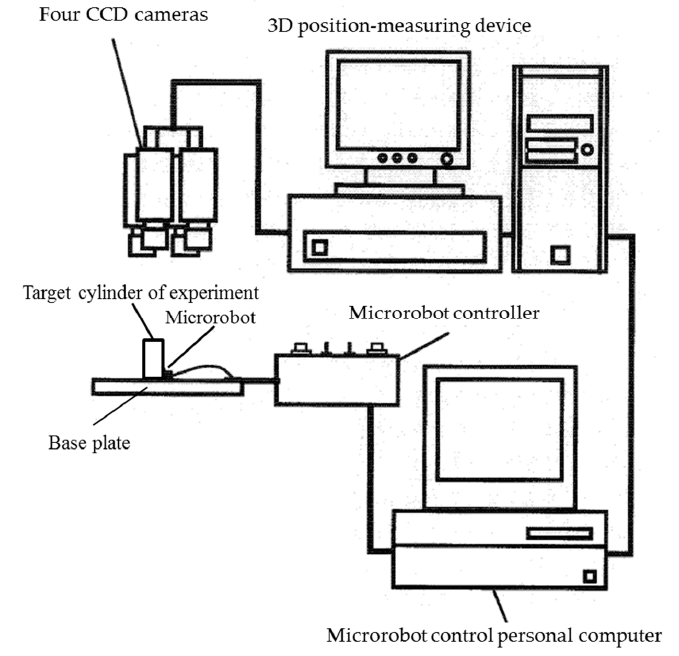
Figure 20. Microrobot vertical driving performance evaluation and control system. The system consisted of six parts: (1) 4 CCD cameras to capture images of the microrobots, (2) a 3D position-measuring device to extract the three color marks from the images and measure the position and orientation of the microrobots, (3) a computer that outputs a control signal to control the microrobot by executing the control program based on the position information, (4) a microrobot controller to drive the driving device of the microrobot after receiving the control signal, (5) the microrobot that is controlled, and (6) the target cylinder simulating a pipe on a base